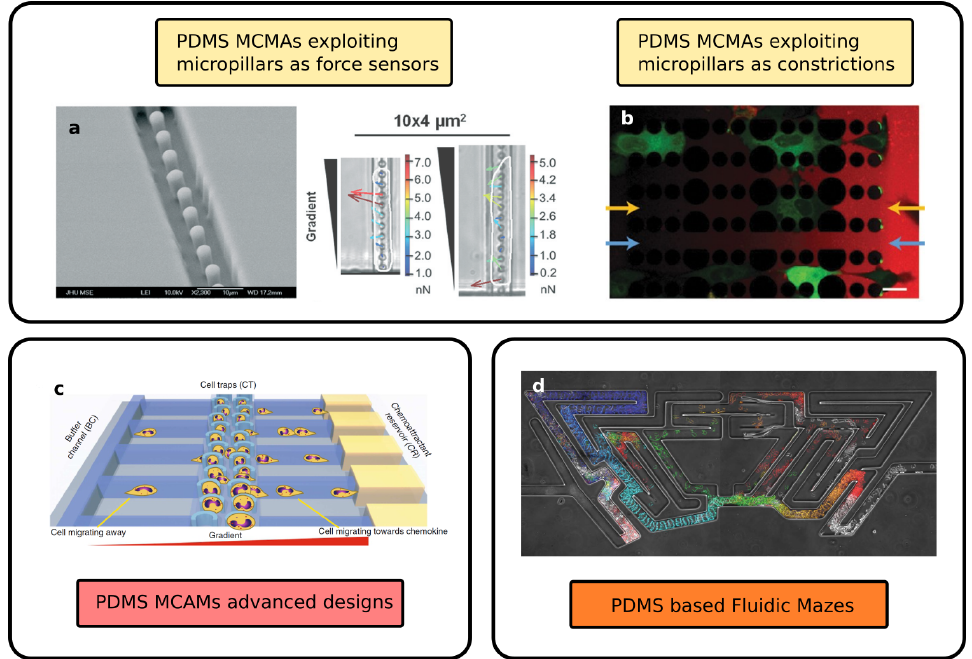
Figure 3. Advanced configurations of PDMS microfluidic assays: ( a ) PDMS pillar structures com- bined with constricting channels, used to study cell adhesion forces. The second panel shows how the displacement of the pillars is related to the force applied by the migrating cell (contoured in white) (Reprinted with permission from Ref. [56] Copyright 2013, The Royal Society of Chemistry); ( b ) Combination of microchannel and pillar structures (colored in black), used to study nuclear rup- ture during cell migration through high confining constriction. The cells are reported in green, while the chemoactractant is reported in red. The arrows highlight the constricting channel and the connec- tion channel used for chemoactractant diffusion in orange and blue, respectively (Reprinted with permission from Ref. [59] Copyright 2015, The Royal Society of Chemistry); ( c ) PDMS chip containing cell traps (in the center) and a double set of constriction channels for bidirectional chemotaxis study (Reprinted with permission from Ref. [57] Copyright 2014, Nature Publishing Group); ( d ) Fluidic maze used to investigate cellular migration decisions. The different time-steps are represented in different fake colors (Reprinted with permission from Ref. [60] Copyright 2020,